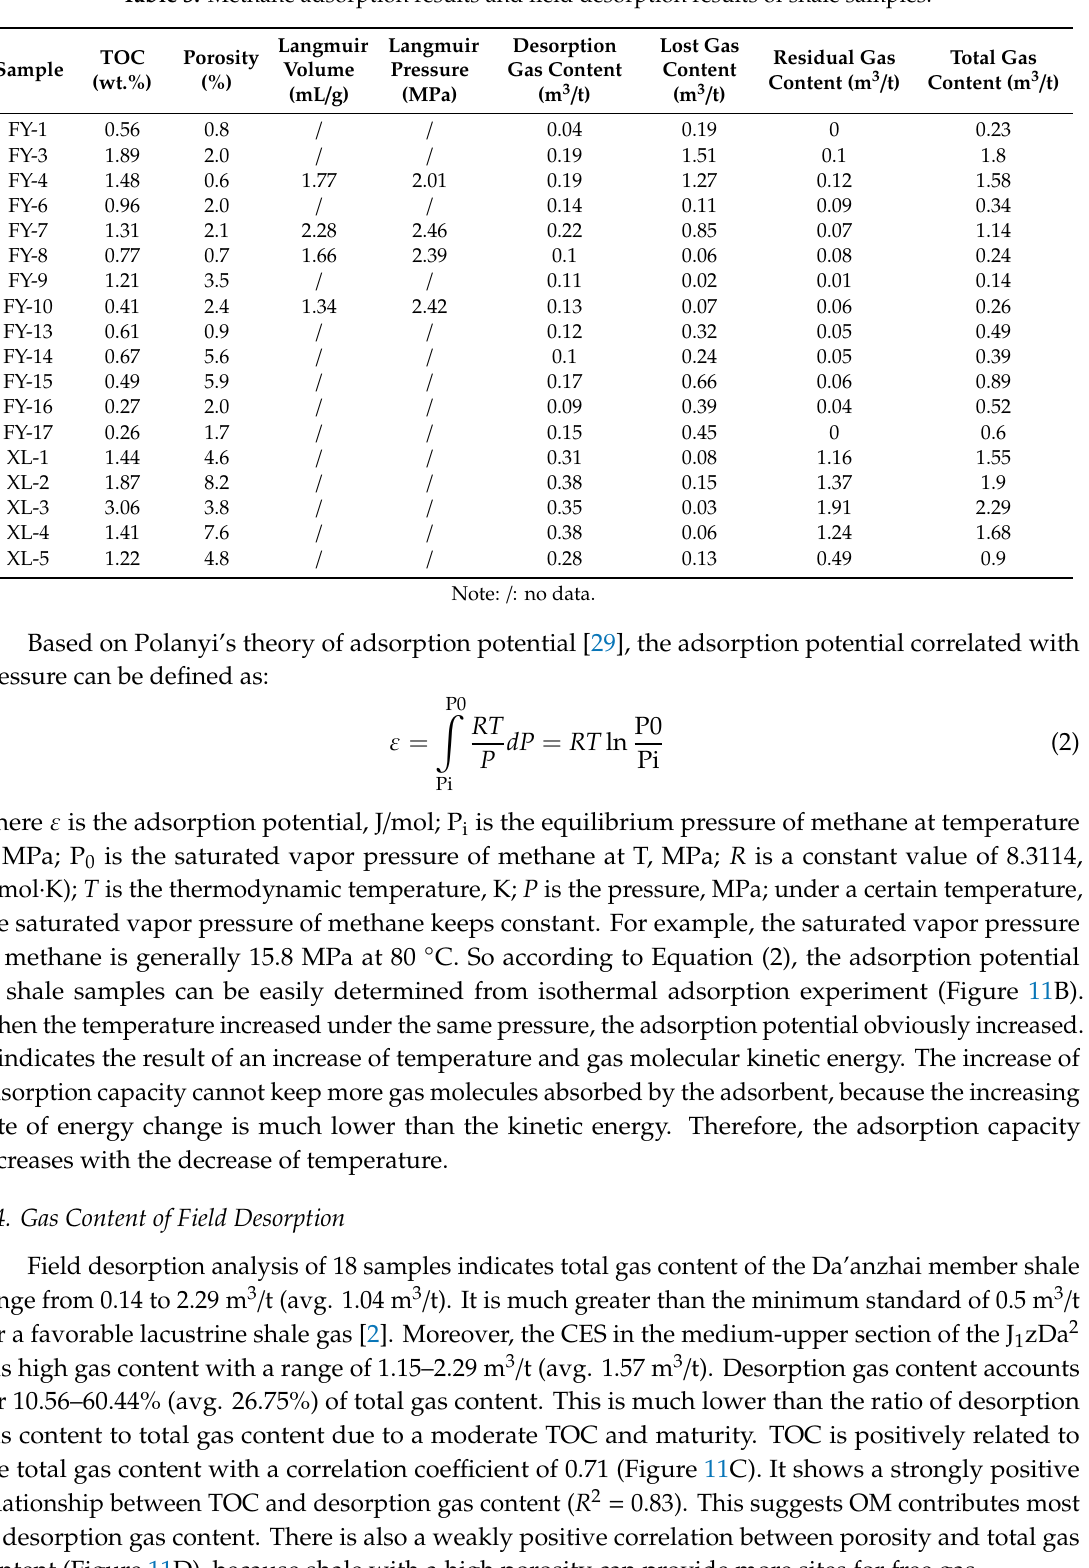
Table 3. Methane adsorption results and field desorption results of shale